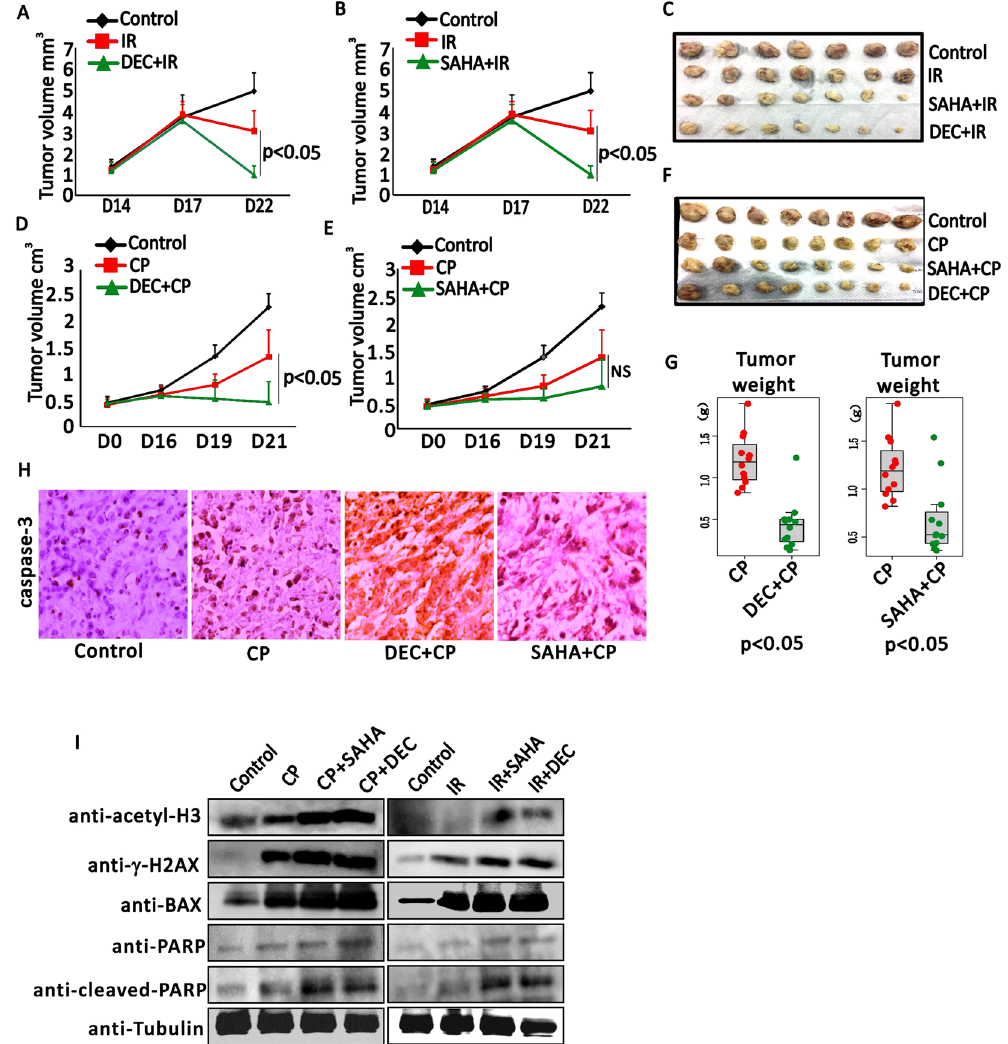
Figure 6. ETD promotes DTD therapeutic effect in engrafted tumors. ( A ) Growth curves of xenograft tumors in mice administrated with solvent (control), IR and SAHA combined with IR, (N = 12). ( B ) Growth curves of xenograft tumors in mice treated with solvent (control), IR and DEC combined with IR (N = 12). ( C ) Tumors are shown after being dissociated from mice with indicated conditions. ( D ) Tumor growth curves of xenograft tumors in mice treated with solvent (control), CP and DEC combined with CP, N = 12. ( E ) Growth curves of xenograft tumors in mice treated with solvent (control), CP and SAHA combined with CP (N = 12). ( F ) Tumors are shown after being dissociated from mice with indicated conditions. ( G ) The box plots show the mean tumor weights ± SEM (N ≥ 10) with indicated treatments including CP, CP combined with DEC or SAHA. ( H ) Representative caspase-3 histochemical staining of xenograft tumors treated with solvent (control), CP, SAHA combined with CP and DEC combined with CP. ( I ) Western blotting detection of acetylated H3, gH2AX, BAX, PARP and cleaved-PARP upon the cells are treated by CP/IR, or CP/IR plus SAHA/DEC, using tubulin as endogenous control, in mouse engrafted